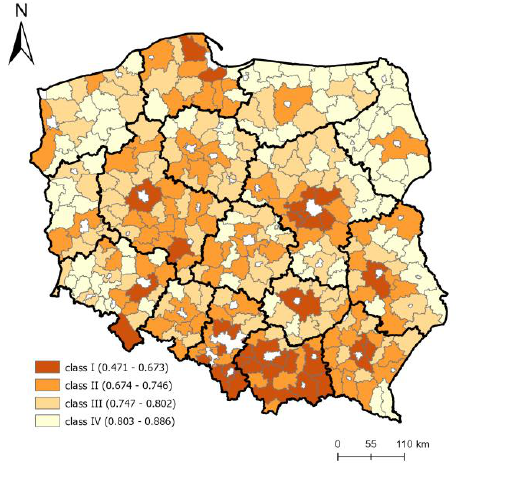
Figure 10. Dependency/relationship between the classification of areas (summary synthetic index WO) and epidemiological risk (number of cases) (COVID-19)—pandemic wave (30 November 2020). Source: own elaboration.